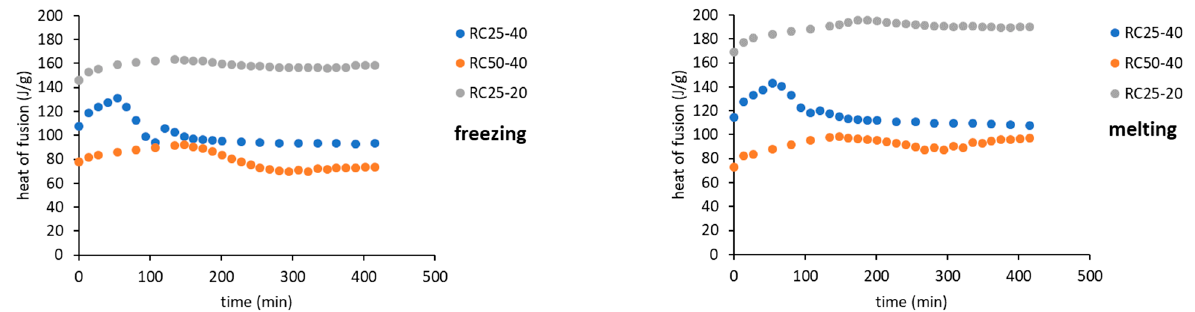
Figure 7. Peak areas (heat of fusion) during freezing and melting of reaction mixtures.